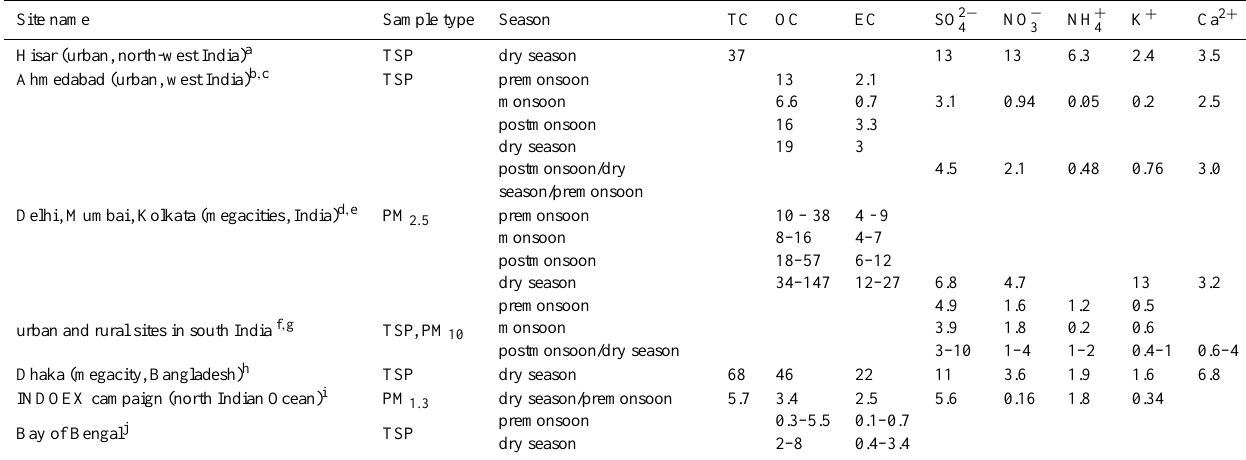
Table 4b. Summary of literature data on main aerosol chemical species concentrations in the Indian subcontinent. a Rengarajan et al., 2007; b Rastogi and Sarin, 2005 (inorganic ion data); c Rastogi and Sarin 2009 (OC and EC data); d Chowdhury et al., 2007 (OC and EC data);